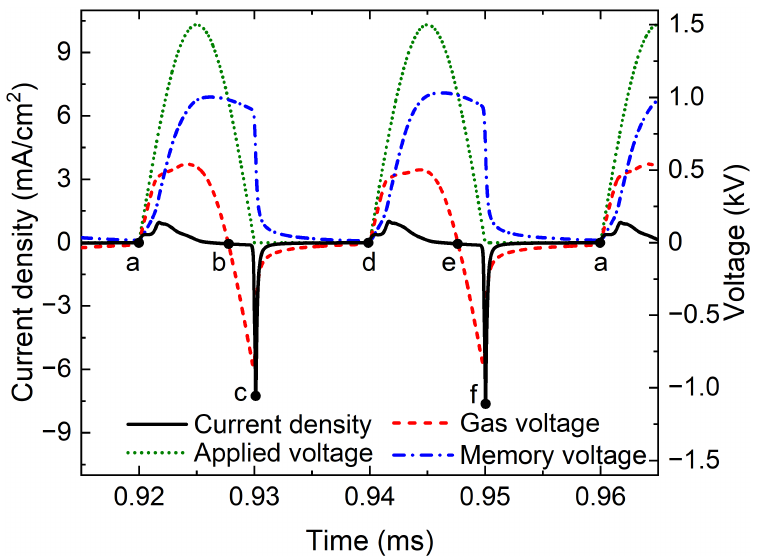
Figure 8. Temporal evolutions of the current density, applied voltage, gas voltage, and memory voltage in PR2 discharge with a gap width of 5.1